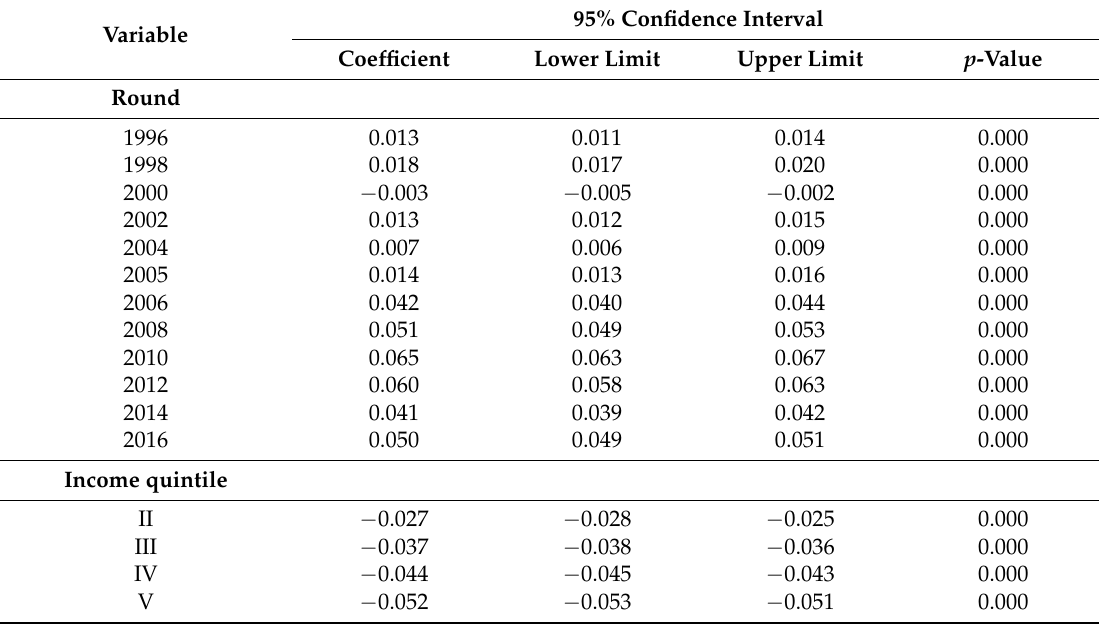
Table 1. Affordability ($/1000 kcal of overall food and beverages/household monthly income) by income quintile and round